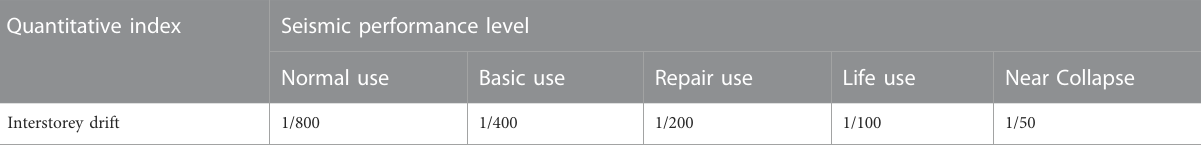
TABLE 3 Limit state of story drift at different performance